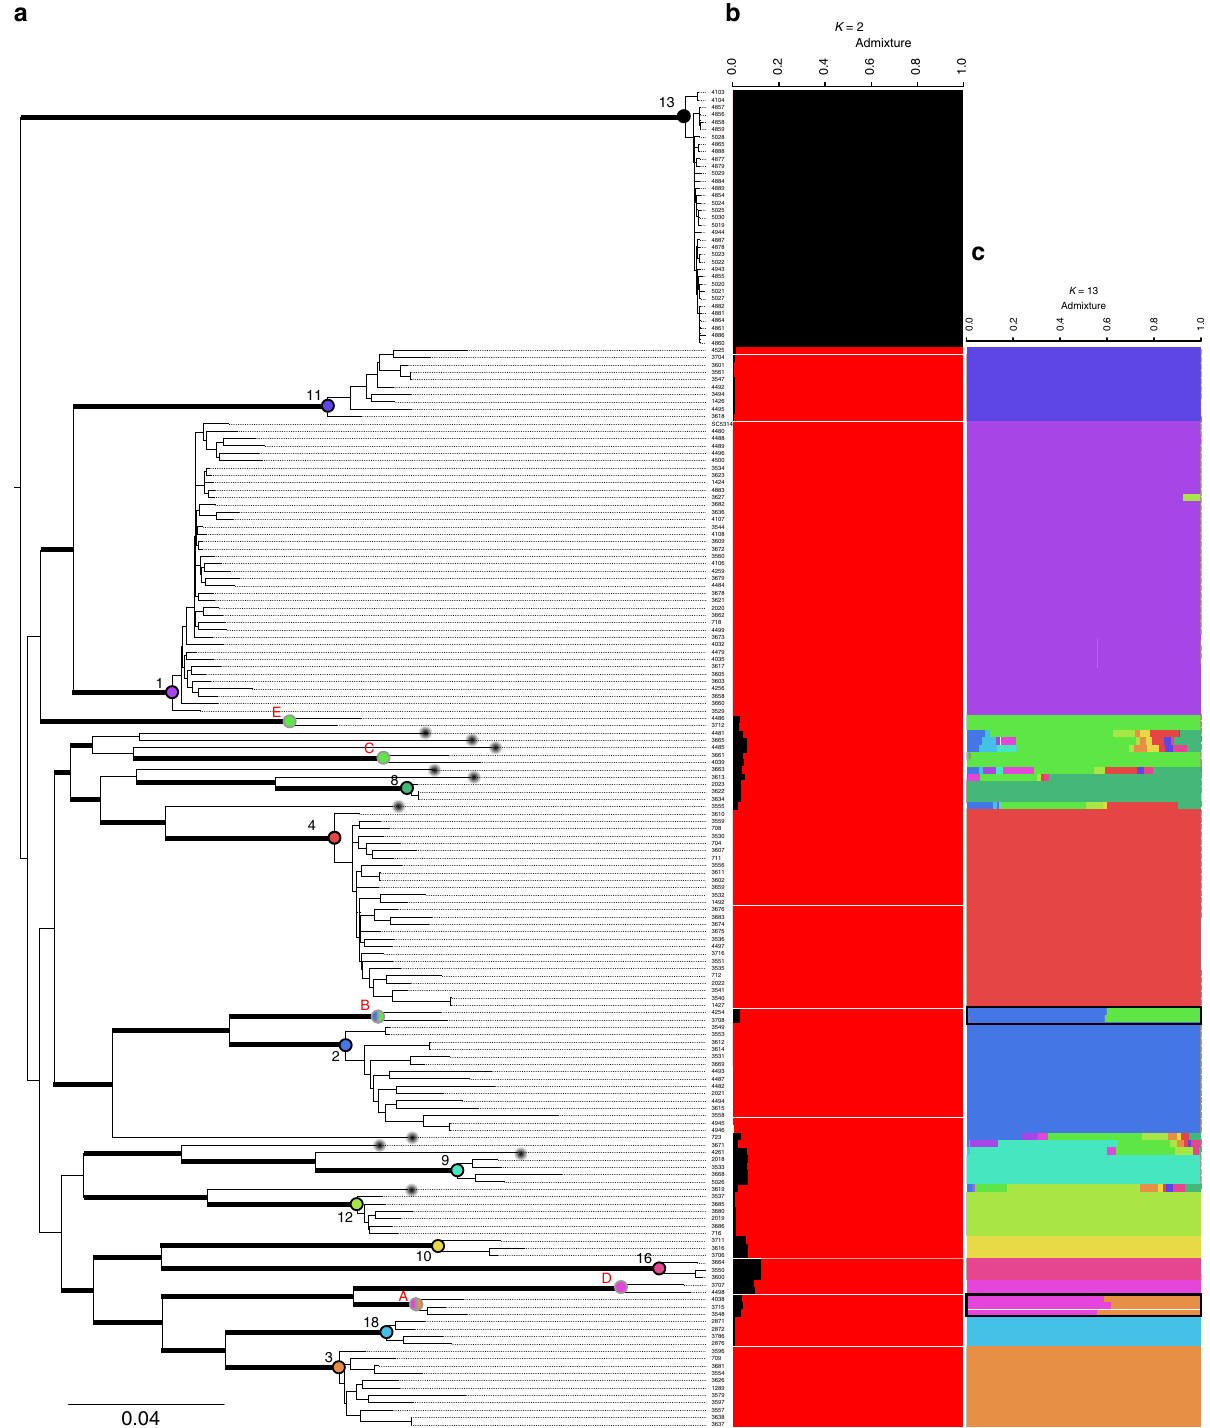
Fig. 2 Phylogenetic relationships and population structure of Candida albicans . a Maximum likelihood tree showing phylogenetic relationships between the 182 isolates used in this study; Thick bars represent bootstrap supports >95% (bootstrap analysis of 1000 resampled datasets); branch lengths are shown and the scale bar represents 0.04 substitutions per site. We used the midpoint rooting method to root the tree. Clusters already described in previous studies using MLST data are written in black (from 1 to 18, incomplete due to sampling) and new clusters described in this study are written in red and named with letters from A to E. Black dots at the end of some branches (10 in total) pinpoint strains which could not be assigned to any cluster. b , c Population structure of C. albicans at b K = 2 and c K = 13. The structure has been inferred using NgsAdmix. Each line represents a strain, as in the ML tree ( a ) and colored bars represent their coef fi cients of membership in the various gene pools based on SNP